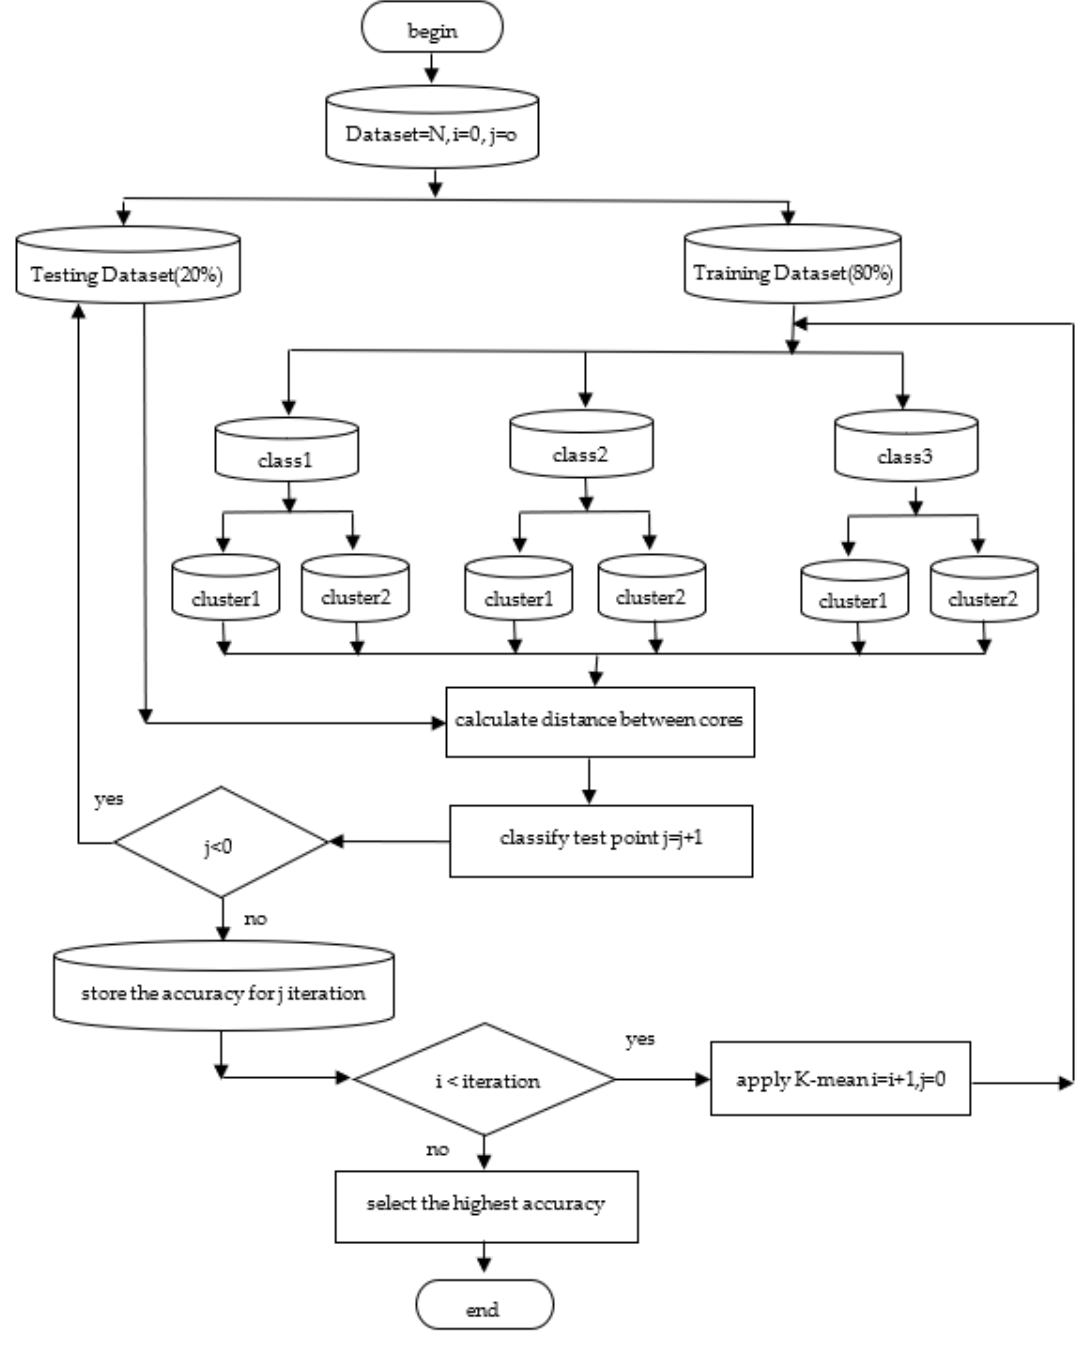
Figure 3. Flowchart of CCA algorithm